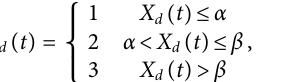
Frontiers in Applied Mathematics and Statistics |